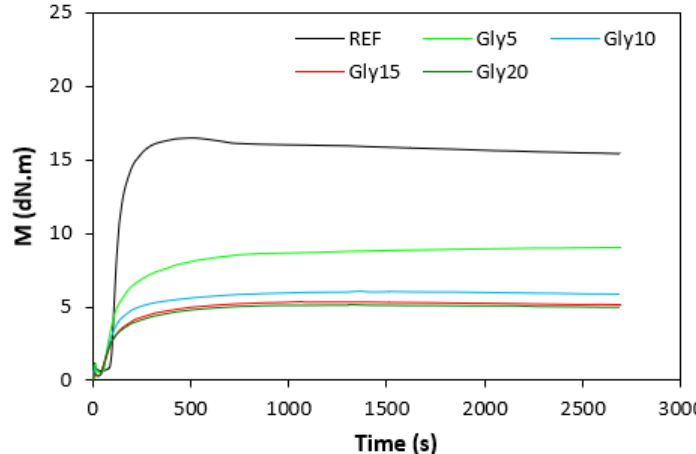
Figure 1. Vulcanization curves of rubber compounds NBR-L30.